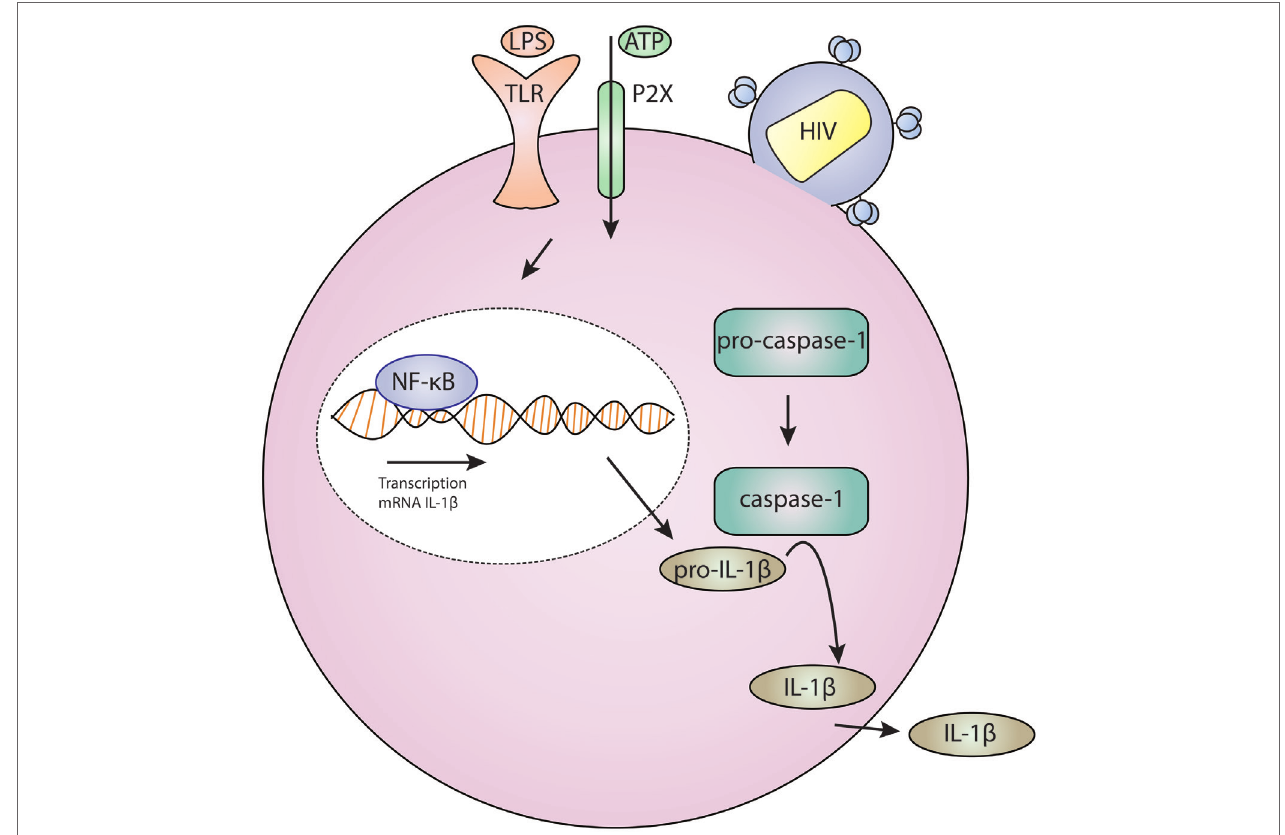
FiGURe 1 | Model for Hiv infection and purinergic receptor signaling in a lymphocyte or macrophage/monocyte . HIV-1 attaches to a cell, and this is associated with P2X activation which results in cation and potentially large molecule flux. Concurrent toll-like receptor (TLR) activation by ligands, such as bacterial lipopolysaccharide (LPS), results in gene regulation through NF-kB. These two signals – TLR and P2X – are required for inflammasome activation which results in cleavage of procaspase-1 to caspase-1 which activates IL-1 β which is then